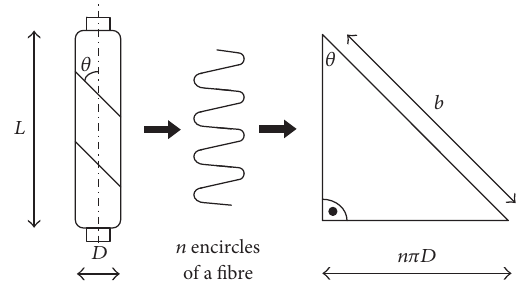
Figure 1: Functional principle of the artificial muscle braid